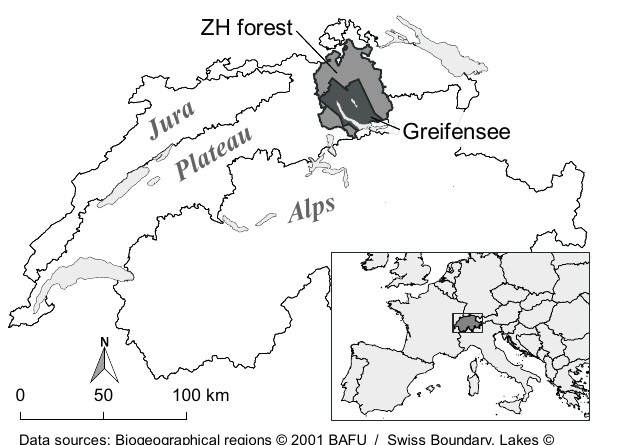
Figure 1. Location of the study regions Greifensee and ZH forest on the Swiss